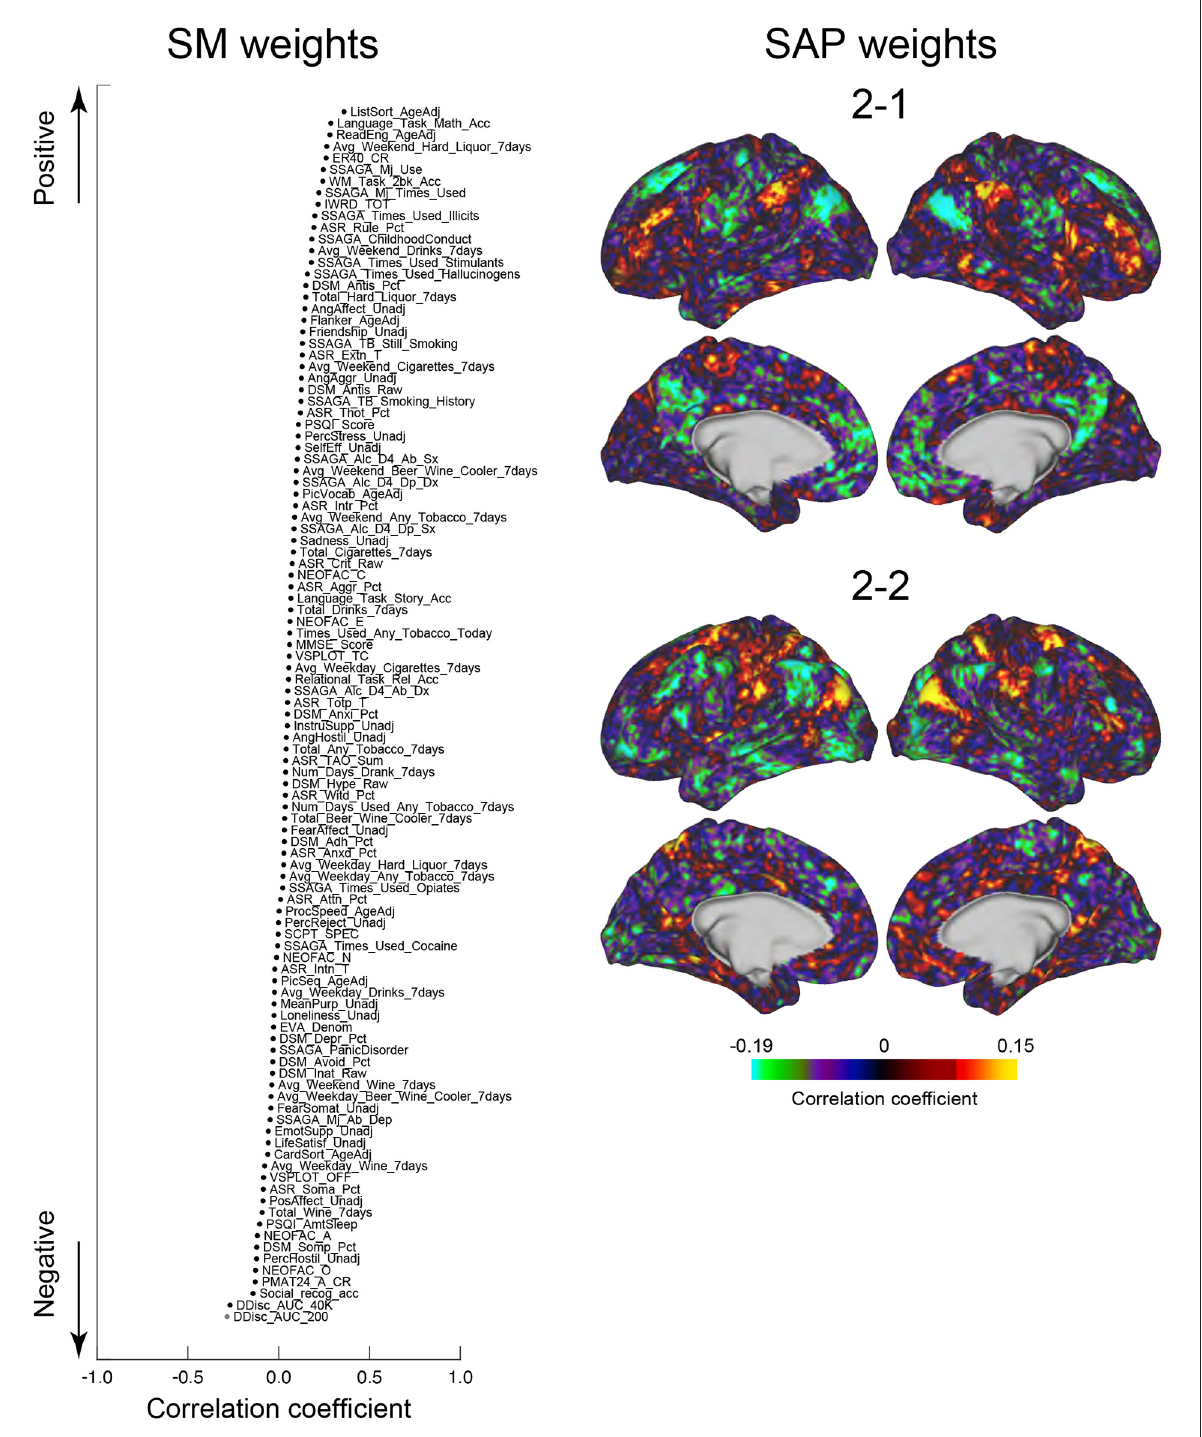
FIGURE6 CCA analysis of SMs and Cluster 2. SM weights of CCA-mode (left) . The horizontal axis indicates the correlation coefficient to CCA-mode. The vertical axis indicates SMs for positive (top) and negative (bottom) directions. A whole-brain map is shown by TSP weight (right) . The color indicates the correlation coefficient with